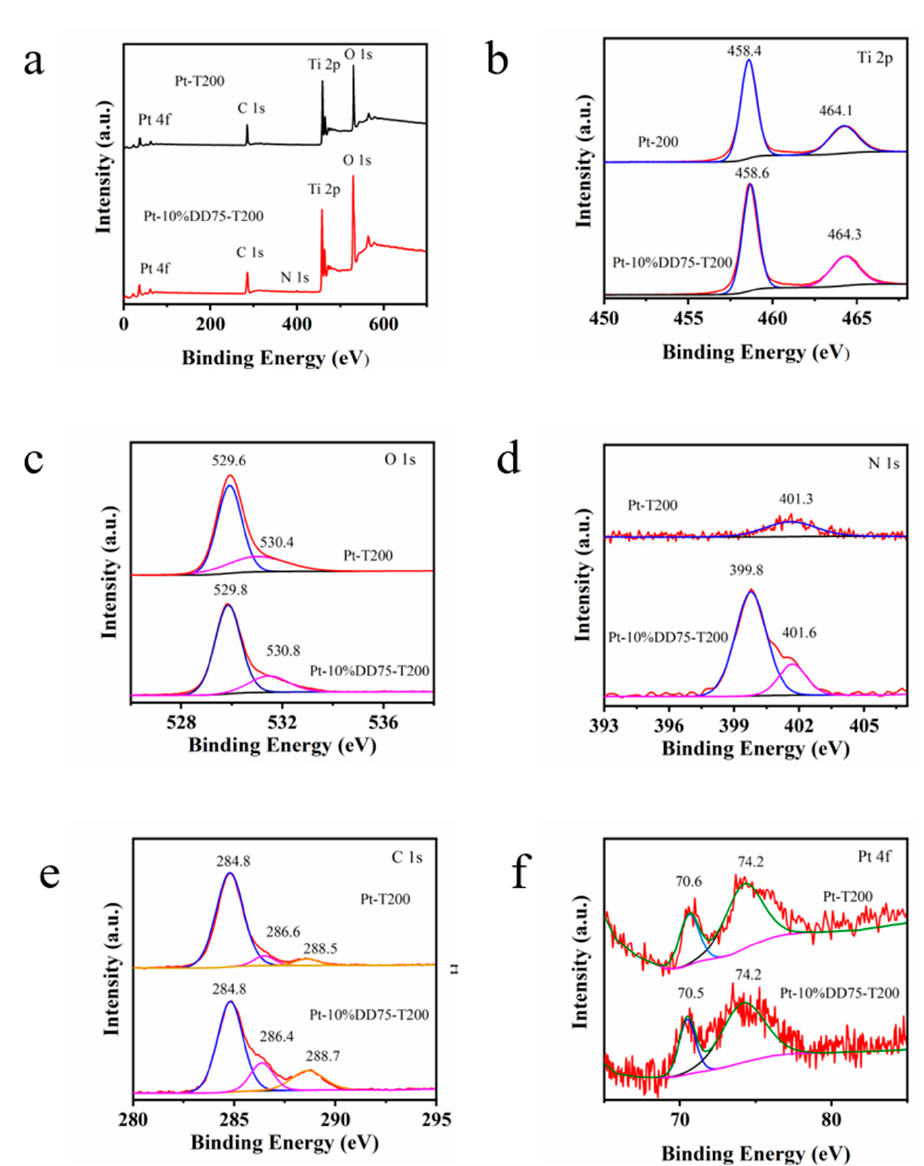
Figure 5. XPS spectra of Pt-10%DD75-T200: ( a ) survey, ( b ) Ti 2p, ( c ) O 1s, ( d ) N 1s, ( e ) C 1s, and ( f ) Pt